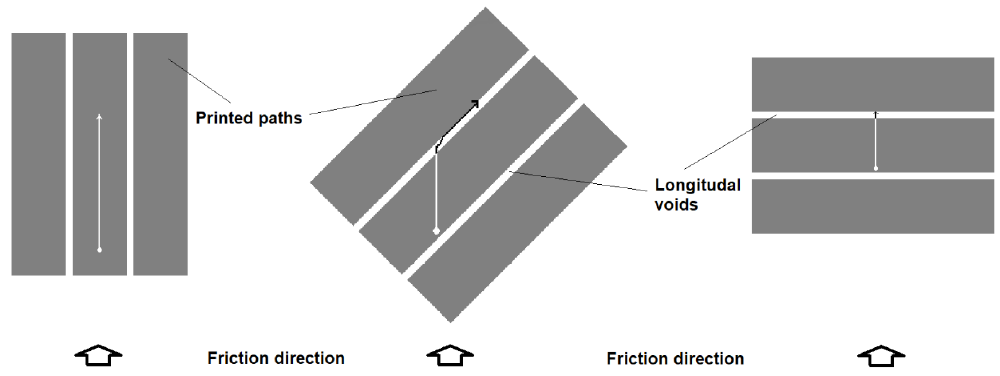
Figure 11. The idea of particle movement after it is separated from the matrix (marked with arrows)—in the three cases of printed paths directions vs. friction direction.